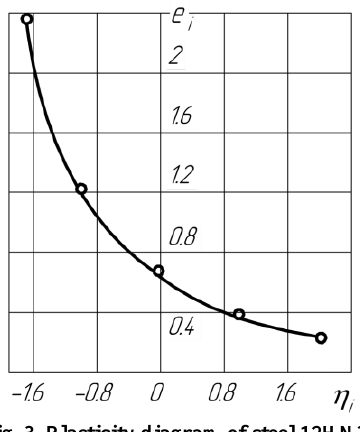
Fig. 3. Plasticity diagram of steel